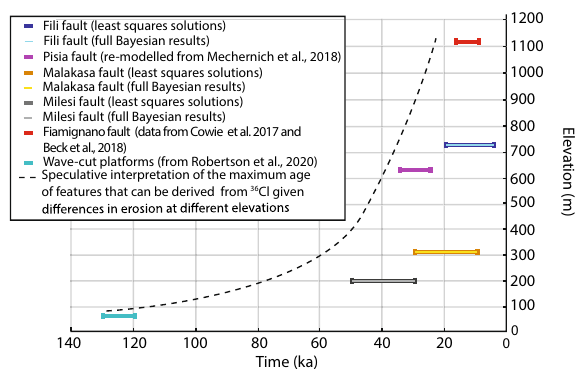
Figure 3. Comparison between the inferred age since the fault scarps started to be preserved, and the elevation of the sampling sites. Together with the three faults subject of study in this paper, we report data from the Fiamignano fault, located in central Italy and studied with 36 Cl where pre-exposure have not been imposed (Cowie et al. 27 ), and re-modelled 36 Cl data from the Pisia fault plane in central Greece (Mechernich et al. 54 ). The bars show the range of possible values reported. We plot the range of possible values from both the least squares solutions (from Fig. 2) and from the highest likelihood solutions (from Supplement S2c). For comparison, we also show the preservation age of ~ 125 ka wave-cut platforms cut into limestones in central Greece, which are at low elevations, and subject to very low erosion rates evidenced by preserved lithophagid borings that were originally only 5–10 cm in depth (Robertson et al. 47